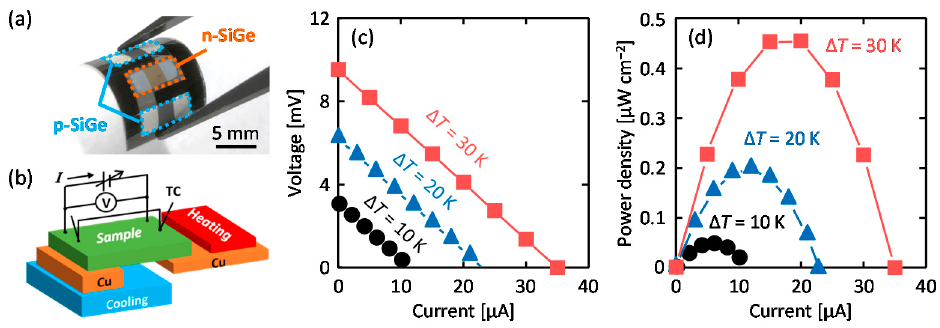
Figure 4. ( a ) Photograph of the flexible TEG using p- and n-type SiGe on a plastic substrate formed by LE using Al and Ag:As. ( b ) Schematic of a system for the output power measurement. ( c ) Voltage–current lines and ( d ) power density–current curves of the TEG obtained at constant temperature differences Δ T of 10 K (circles), 20 K (triangles), and 30 K (squares), where the sample stage was kept at 300 K. The data points represent the average of 50 measurements, and the error is within acceptable limits.